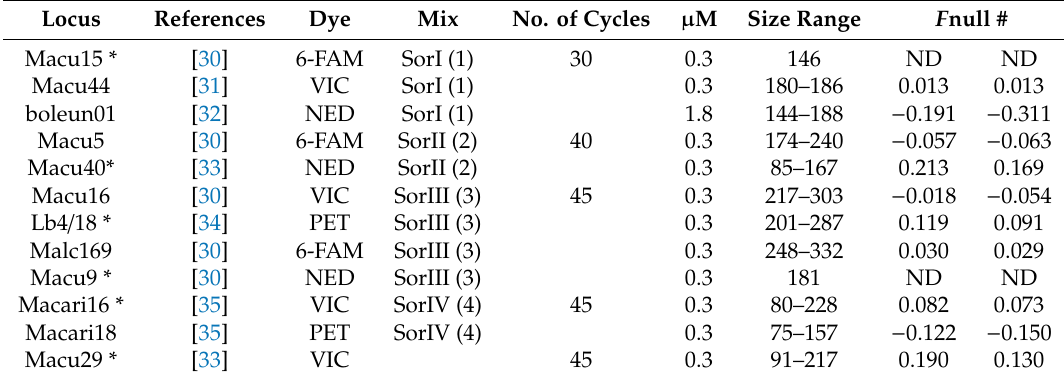
Table 1. Twelve microsatellite loci amplified in 65 individuals of Scolitantides orion from the two Polish